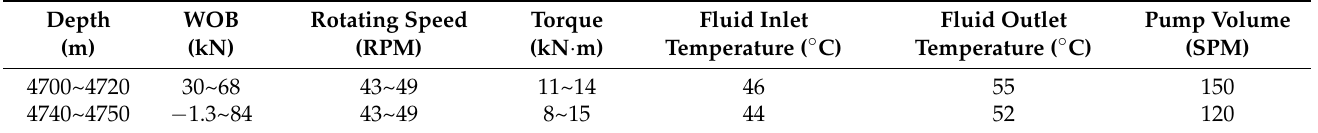
Table 4. Drilling parameters of vibration data collection